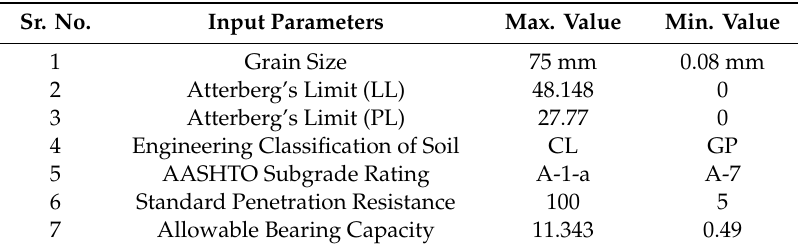
Table 2. Outlines of Geodatabase Input Parameters.